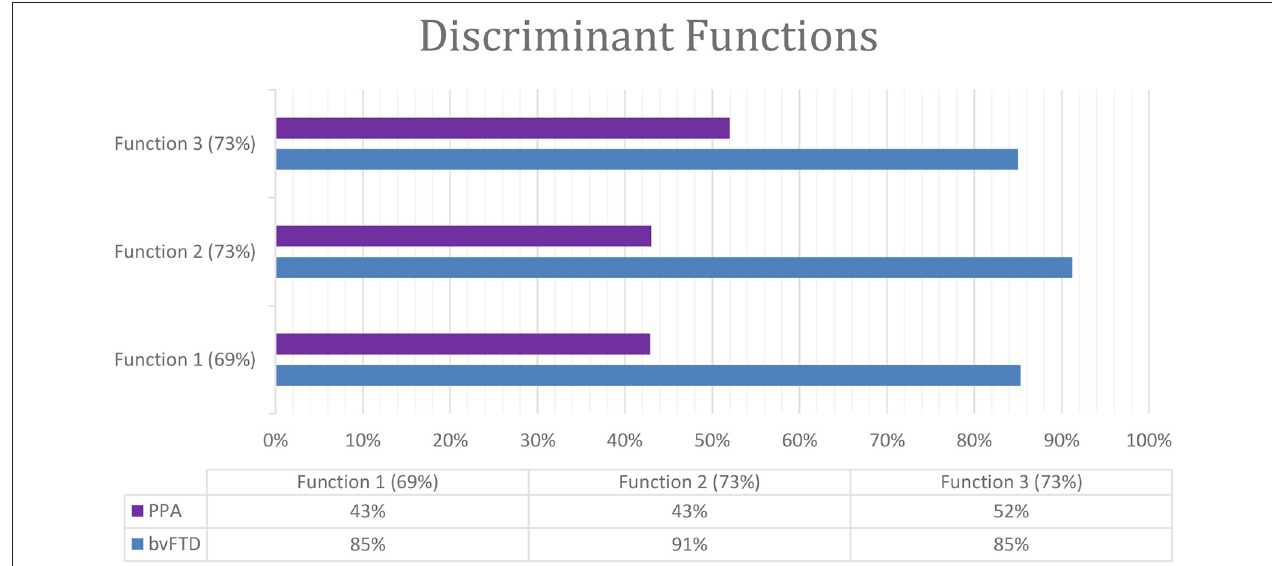
FIGURE 2 | Classification of dementia by the discriminant functions as a combination of cognitive test.